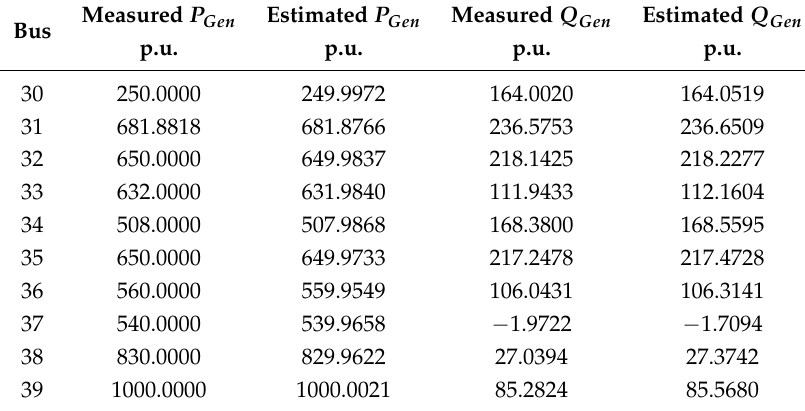
Table A4. Comparison of Measurements and their Estimations of IEEE 39 Test System Generators for the Summer Case after First Step of the Presented Method using Base Model Calculated for 20 ◦ C.